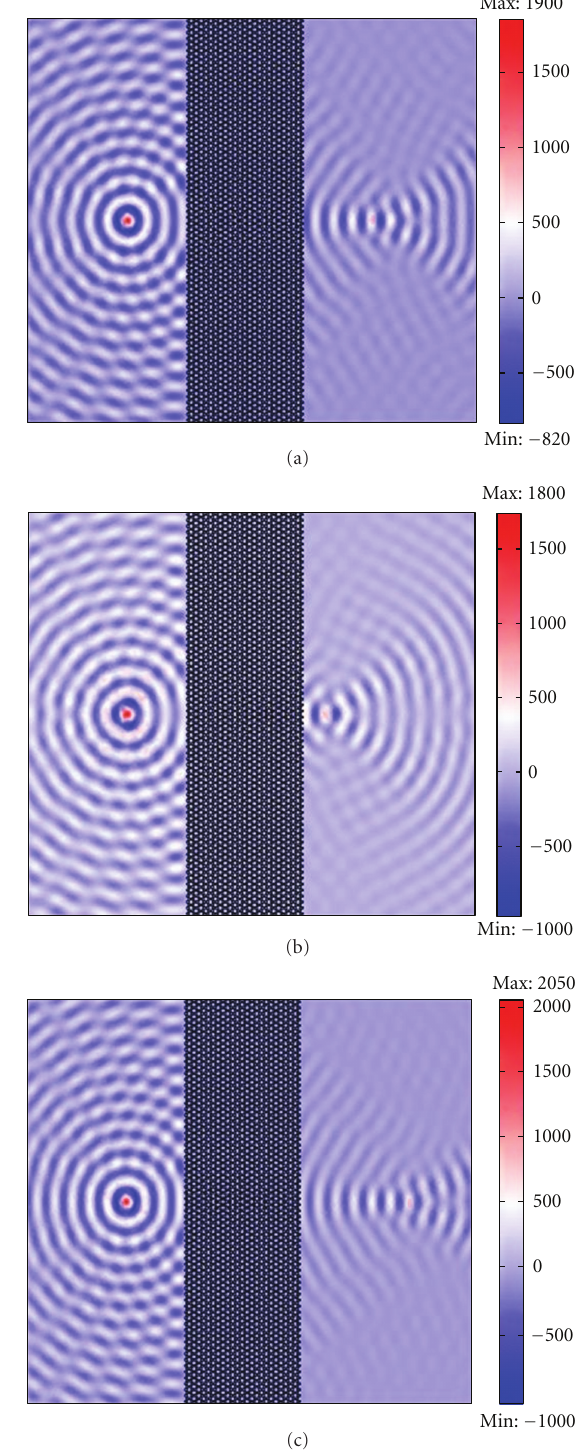
Figure 10: The FDTD simulations of point sources of three di ff erent frequencies placed in front of a 2D PhC slab of hexagonal lattices. The thickness of the slab is d = 12 × distance between source and the first slab interface is d 1 = d/ 2. The air-PhC interface is perpendicular to the Γ -M direction, and the normalized frequencies are, respectively, (a) ω = 0 . 315(2 πc /a ), (b) ω = 0 . 300(2 πc /a ), and (c) ω = 0 . 320(2 πc /a